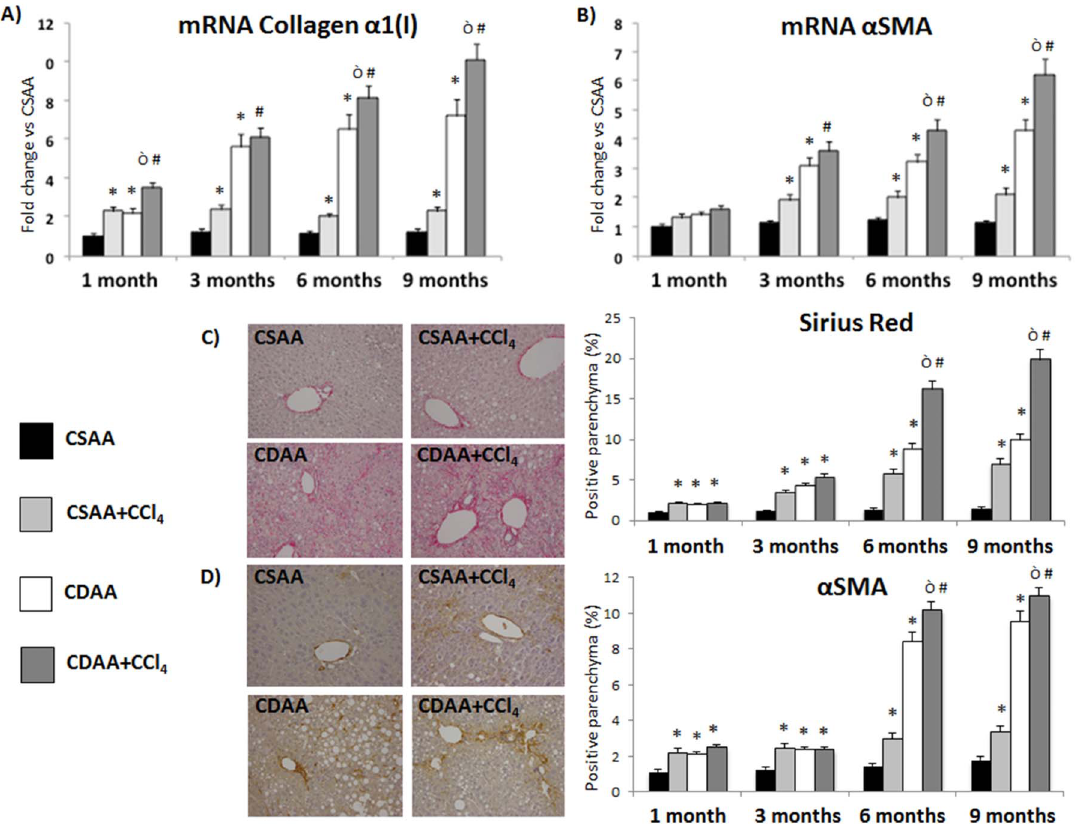
Figure 6. Treatment with CDAA or CDAA + CCl 4 induces hepatic fibrosis in mice. A–B) qRT-PCR expression shows a progressive increase, in a time dependent manner, of the amount of Collagen a 1(I) (A) and a SMA (B) mRNA in the group of CDAA, with the evidence of a promoting effect exerted by CCl 4 starting from month 6. Conversely, mice treated with control diet (CSAA) do not show any time-dependent increase neither in the level of Collagen a 1(I) nor of a SMA, not even after chronic CCl 4 injection. C–D) Morphometric analysis shows increased collagen deposition by Sirius Red staining (C) and increased HSC activation by a SMA Immunohistochemistry (D) in the liver of CDAA treated mice in comparison to CSAA treated mice. This condition is even enhanced in the liver of mice treated with CDAA + CCl 4 . Data represent mean 6 SD; *p , 0.05 vs CSAA; # p , 0.05 vs CSAA + CCl 4 ; o` p , 0.05 vs CDAA.